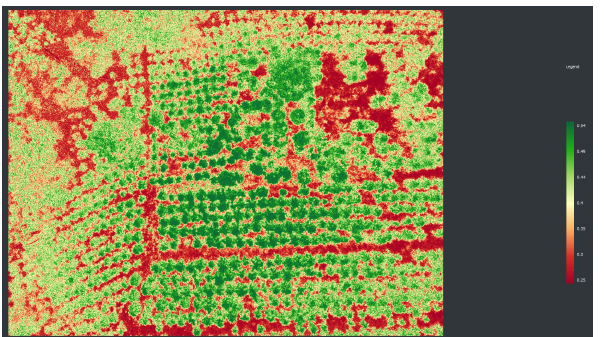
Figure 7. Cloudy NDVI image